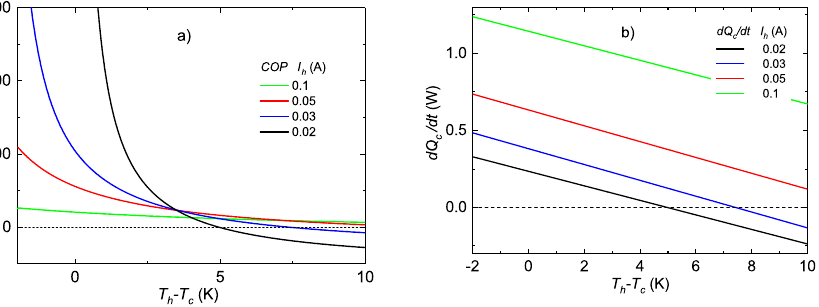
Figure 5. ( a ): COP of the pure TE sandwich on increasing ∆ T = T h − T c at B = 0, for several current supplies I h = I c . ( b ): Heat power extracted from the cold source for the same